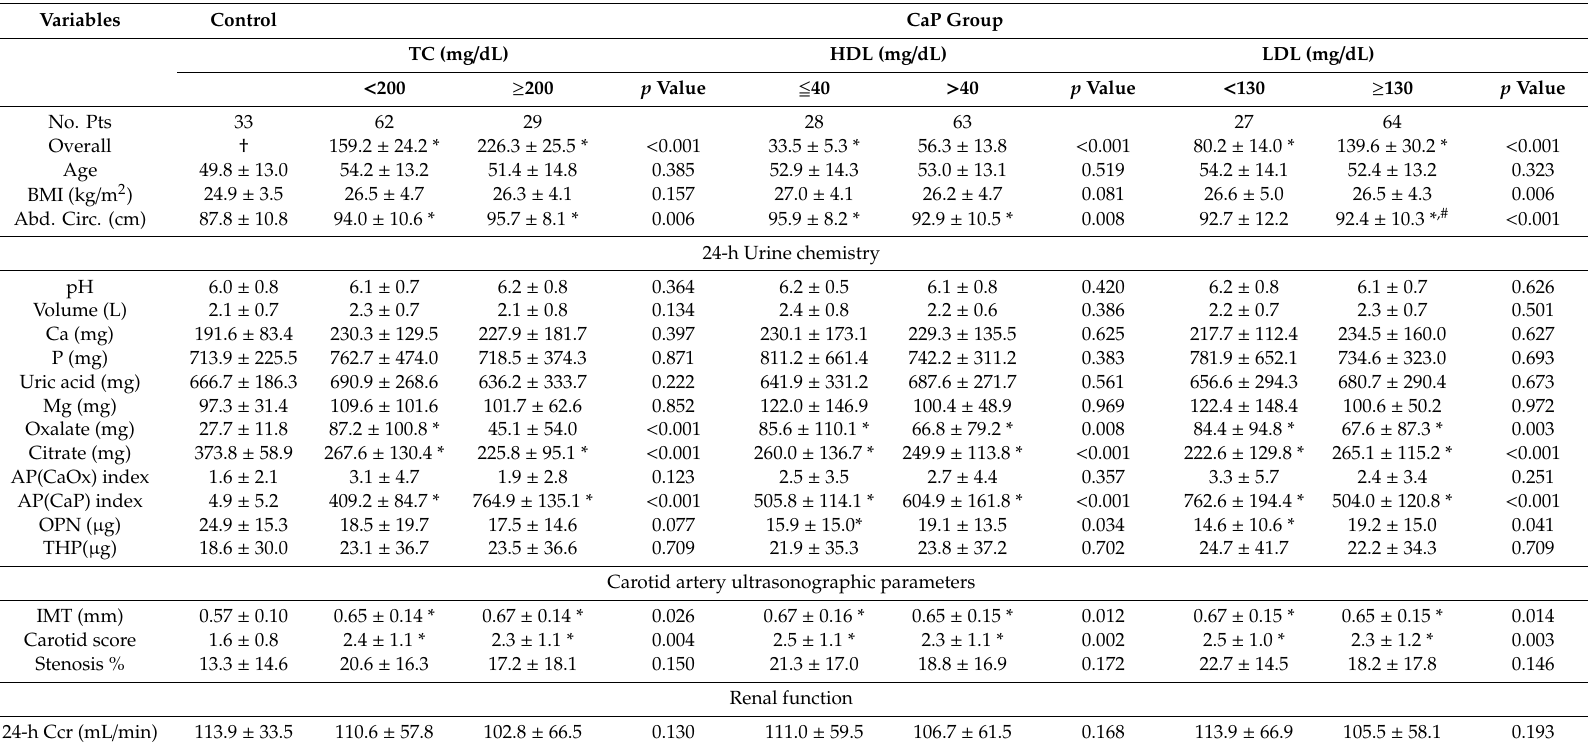
Table 3. Demographic, 24-hour urinary chemical data, and carotid score in the CaP